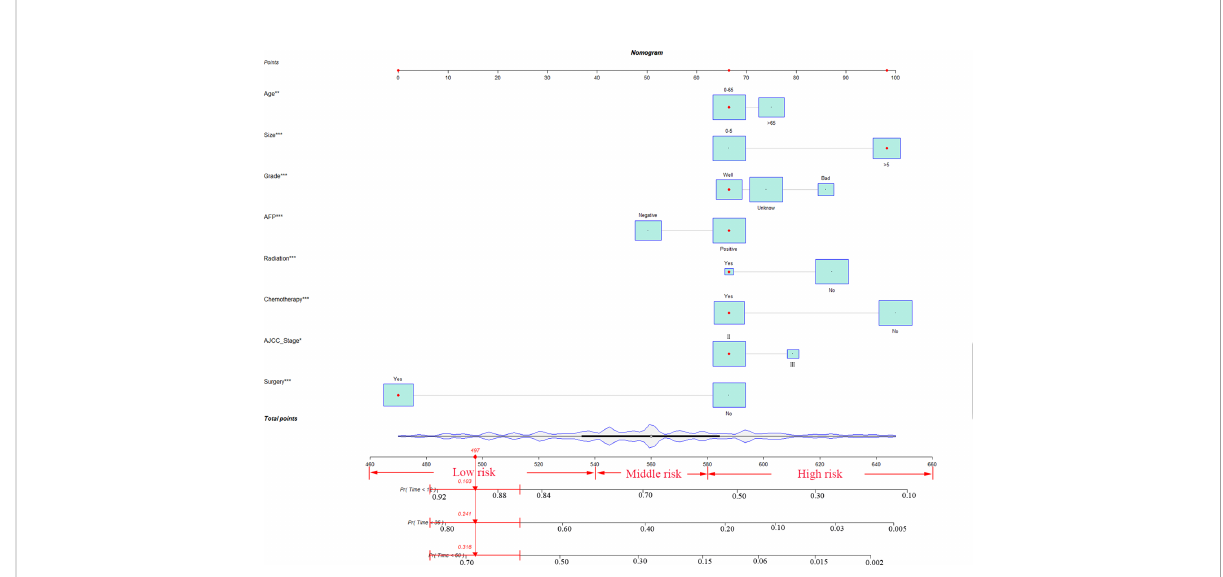
FIGURE 2 The nomogram for HCC patients with MVI. * P < 0.05, ** P < 0.01, *** P < 0.001, HCC, hepatocellular carcinoma; MVI, microvascular invasion.